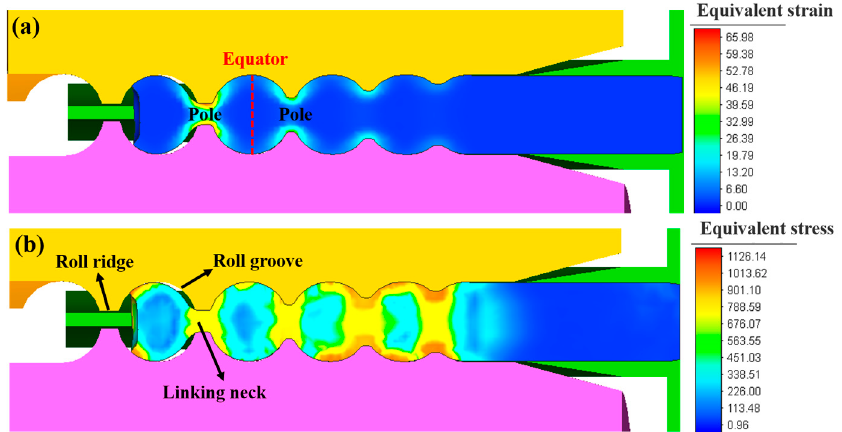
Figure 7. The strain and stress contour along the longitudinal section of the steel ball: ( a ) equivalent strain and ( b ) equivalent stress.